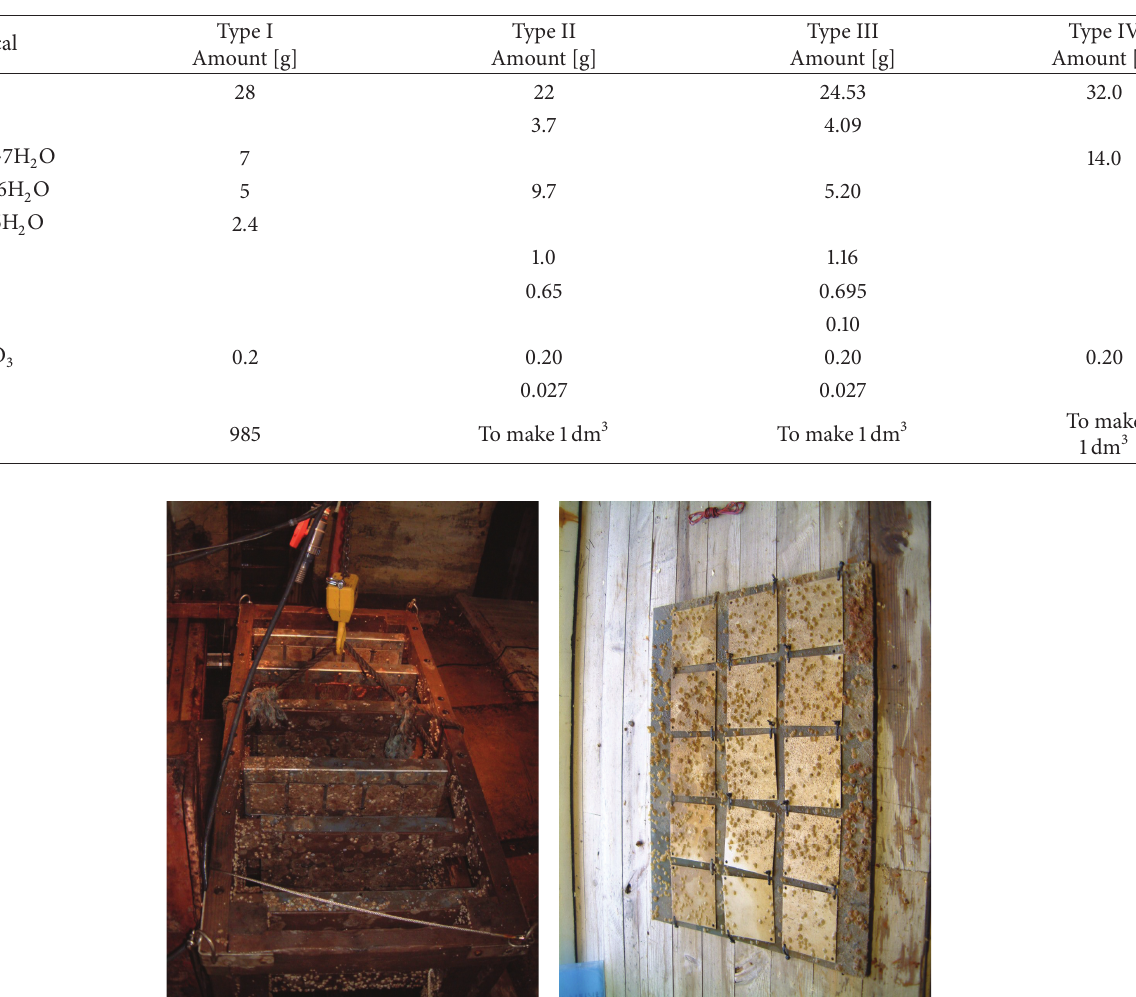
Table 2: Composition of some artificial seawater samples.